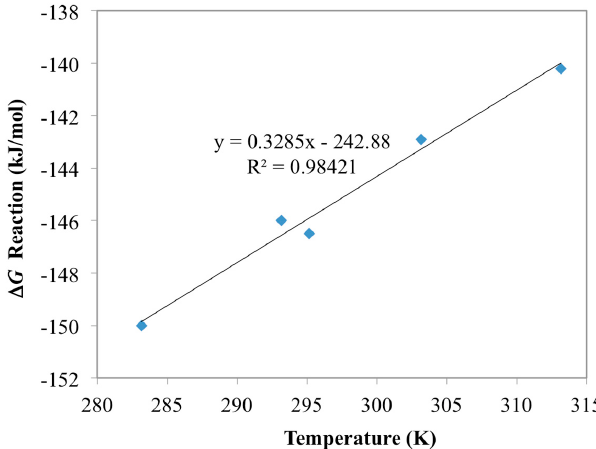
Figure 1. Optimum values for the free energy of the UO 2 (AO) 2 forming reaction in Table 3. These values were obtained iteratively through comparison with the AF160 experimental data using a gradient search method.